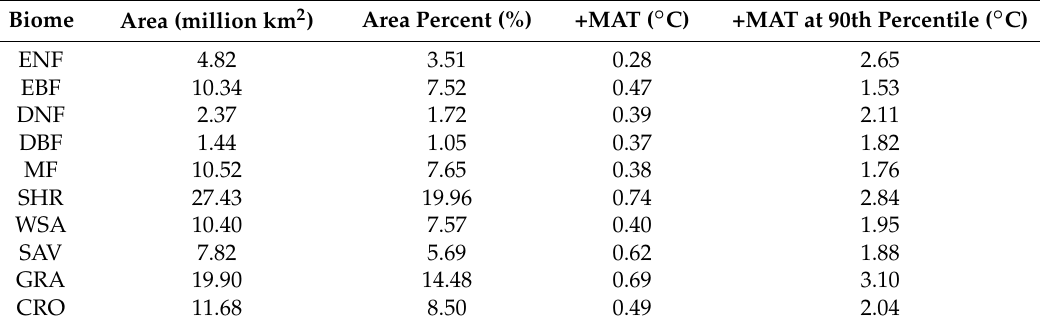
Figure 1. Increment of mean annual temperature (+MAT) from 1982–2013 at the global scale (increments significant at p < 0.01 only). Figure 2. Study sites for the various vegetation biomes, all identified within the 90th percentile of the increment of MAT (+MAT). Table 1. Statistics of area, area percent, +MAT, and +MAT at the 90th percentile for various vegetation biomes at the global scale.